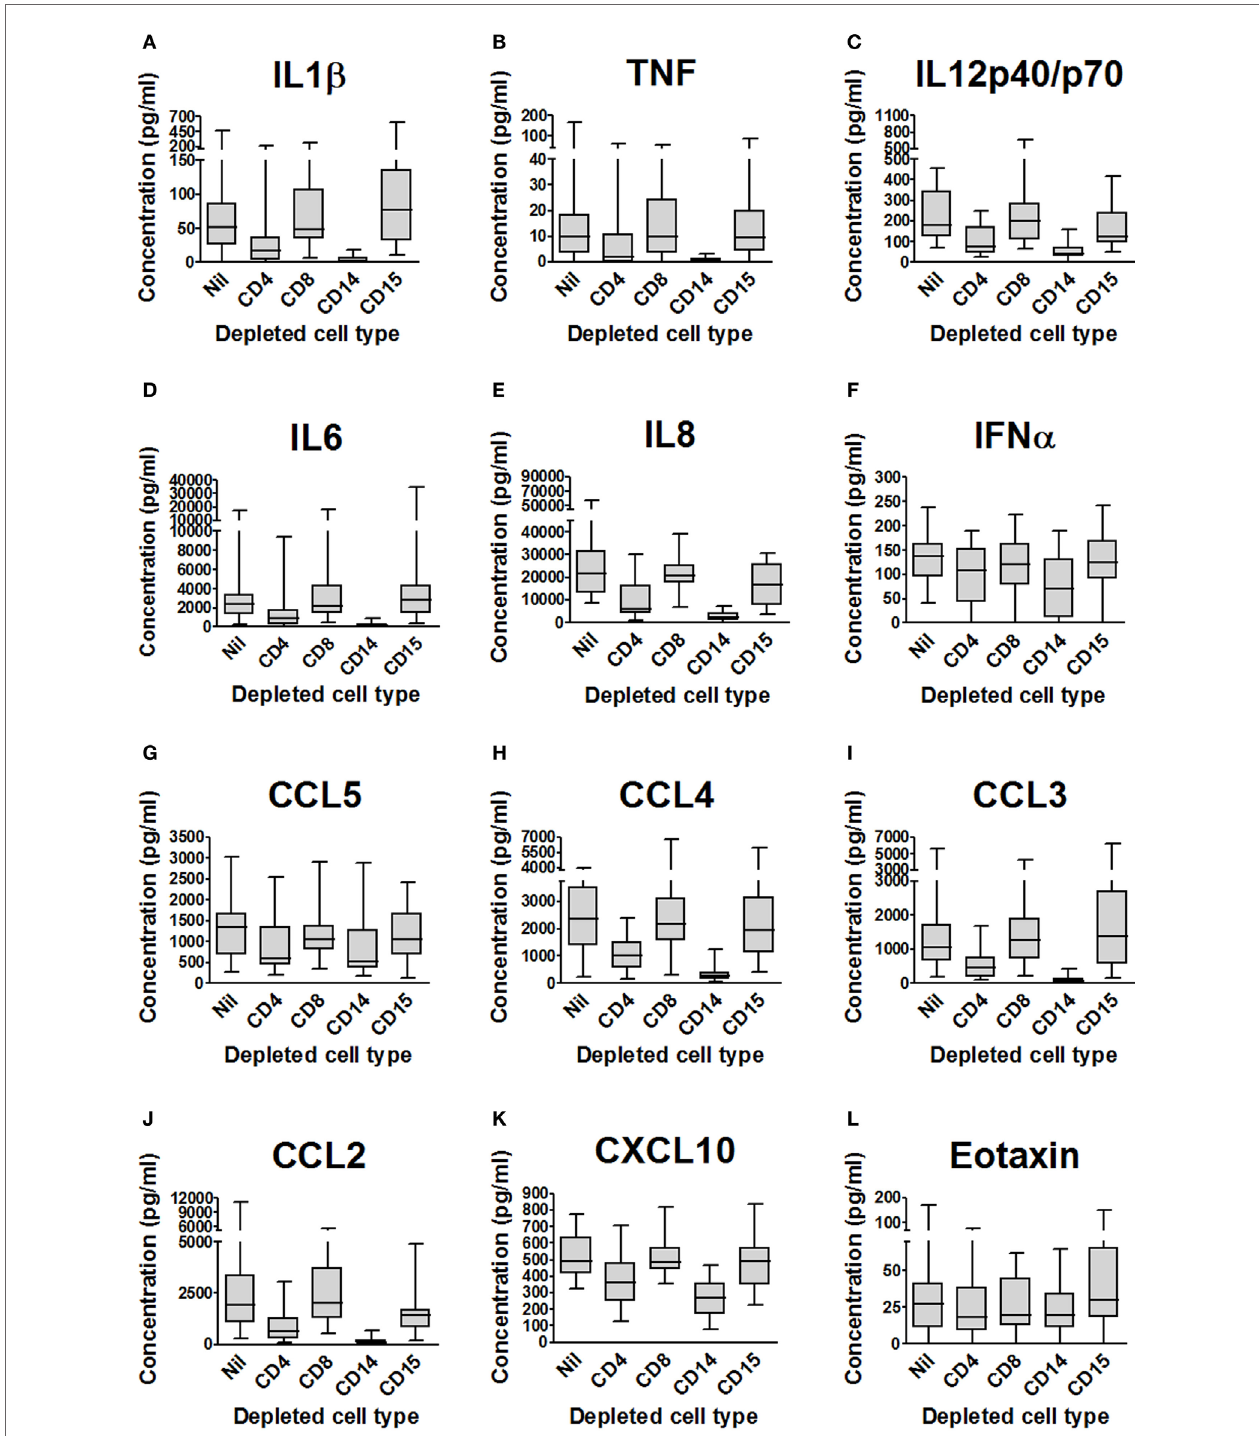
found to contribute to the separation of groups in PCA. Maximal cytokine responses were seen in the non-augmented blood. Viable neutrophil augmentation was broadly